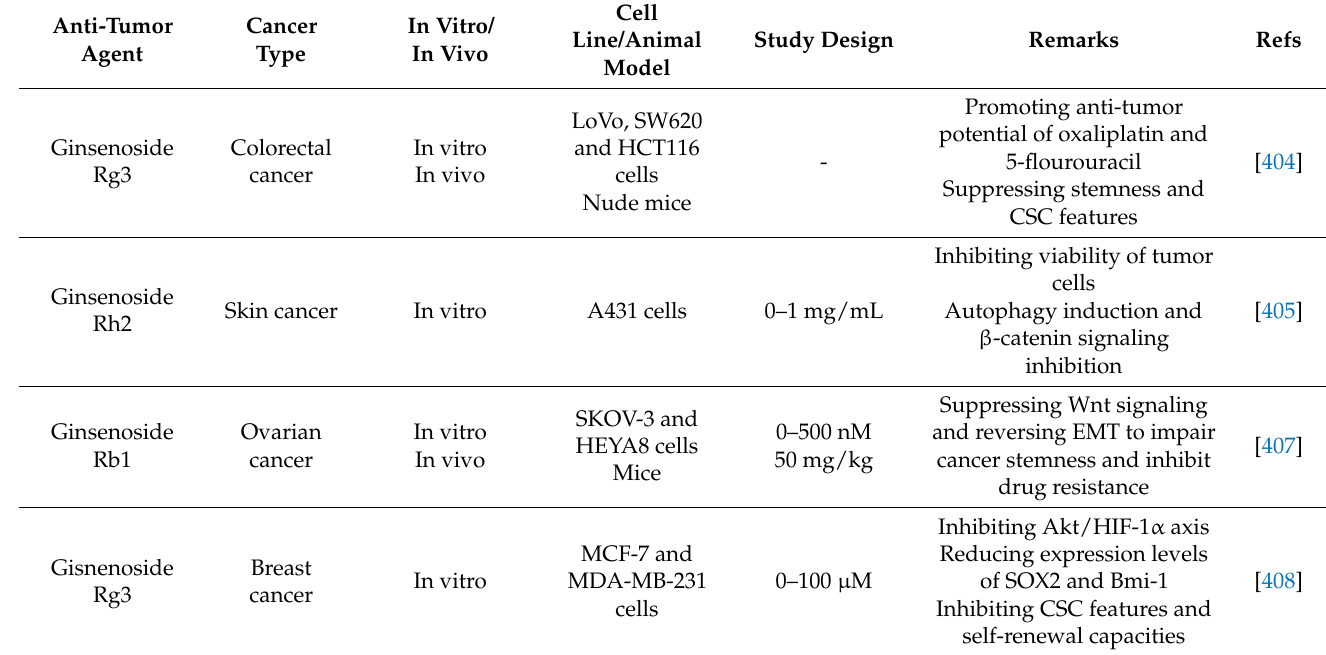
Figure 7. The berberine and ginsenosides as modulators of CSCs in tumor eradication. Table 9. Ginsenosides as potential inhibitors of CSCs in different